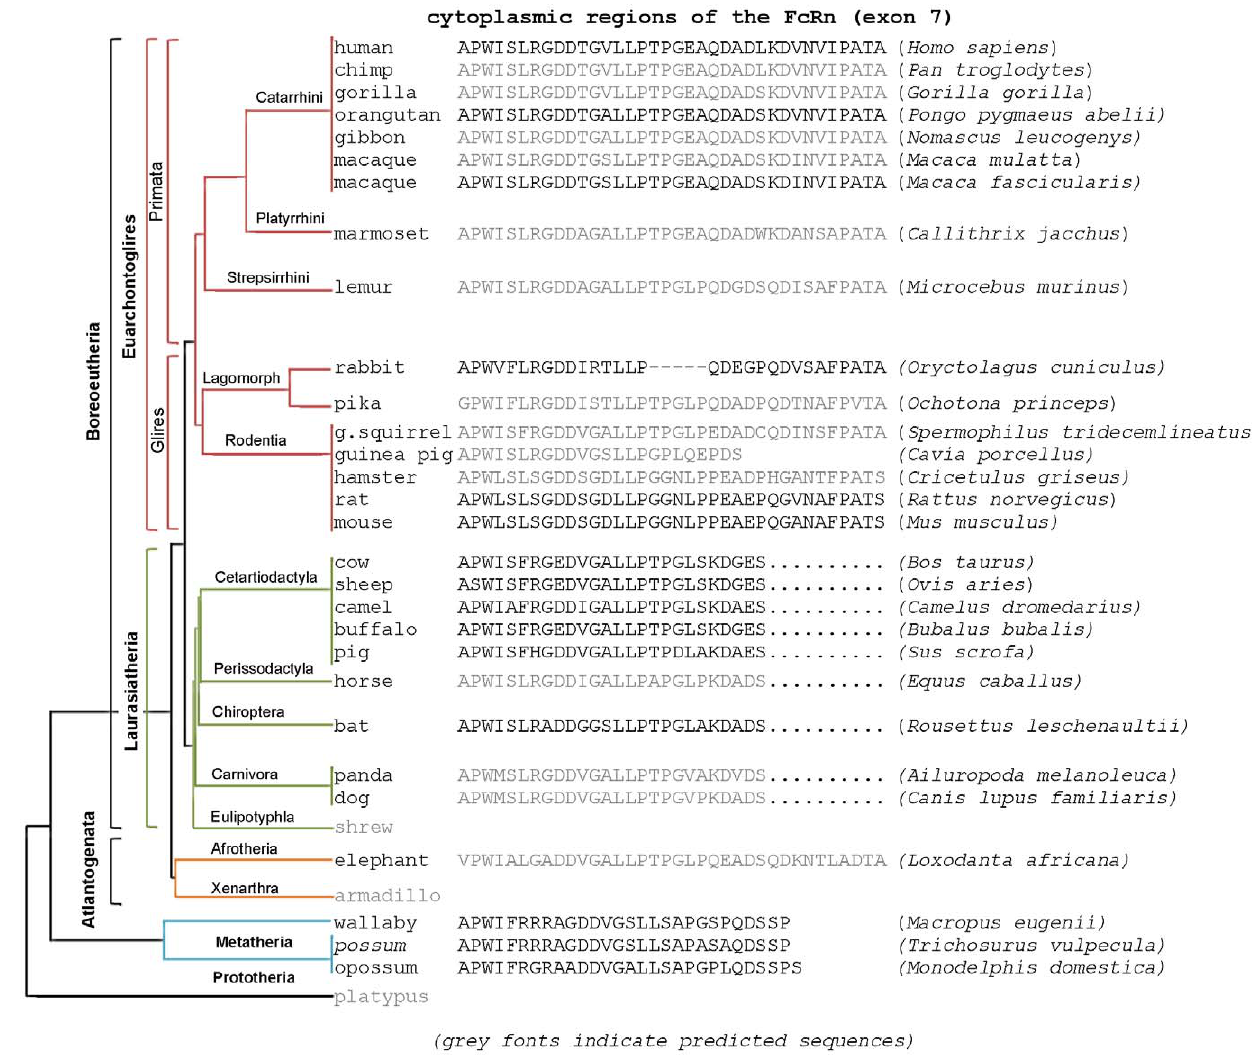
Figure 3. Cytoplasmic domains of the FcRn sequences most likely reflect their phylogenetic position. Marsupials (possum, opossum, and wallaby) have relatively short cytoplasmic domains composed of 27–28 amino acid residues. The next phylogenetic step resulted in clades Atlantogenata and Boreoeutheria. The only (predicted) sequence we found belonging to Atlantogenata (elephant) shows a 7–8 amino acid longer cytoplasmic domain as compared to Marsupials. Boreoeutheria is composed of the sister taxa Laurasiatheria and Euarchontoglires. Species belong to Euarchontoglires analyzed so far (human, chimp, gorilla, orangutan, gibbon, rhesus, marmoset, lemur, rabbit, pika, squirrel, hamster, rat and mouse) preserved these extra amino acids of the FcRn C-terminal with the exception of the guinea pig (based on its predicted amino acid sequence). Rabbit lost five amino acids in a more N-terminal (or middle) part of the cytoplasmic domain. As pika (Ochotona), another Lagomorphs, possesses these residues, the five amino acid deletion is thus specific of either rabbit or Leporidae family. Animals belong to the Laurasiatheria clade (bovine, sheep, pig, horse, bat, dog and panda) lost 10 amino acids of their FcRn C-terminals. Phylogenetic tree was created based on Prasad et al. [45] where some branch lengths were optimized for clarity and space.